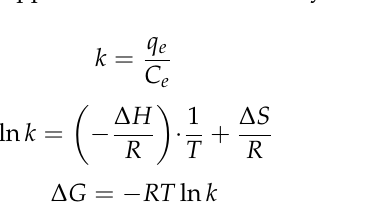
Figure 8. ( a ) Adsorption capacity of silicic acid as a function of the temperature; ( b ) Fitting dia- gram of adsorption thermodynamic model of the silicic acid adsorption process.